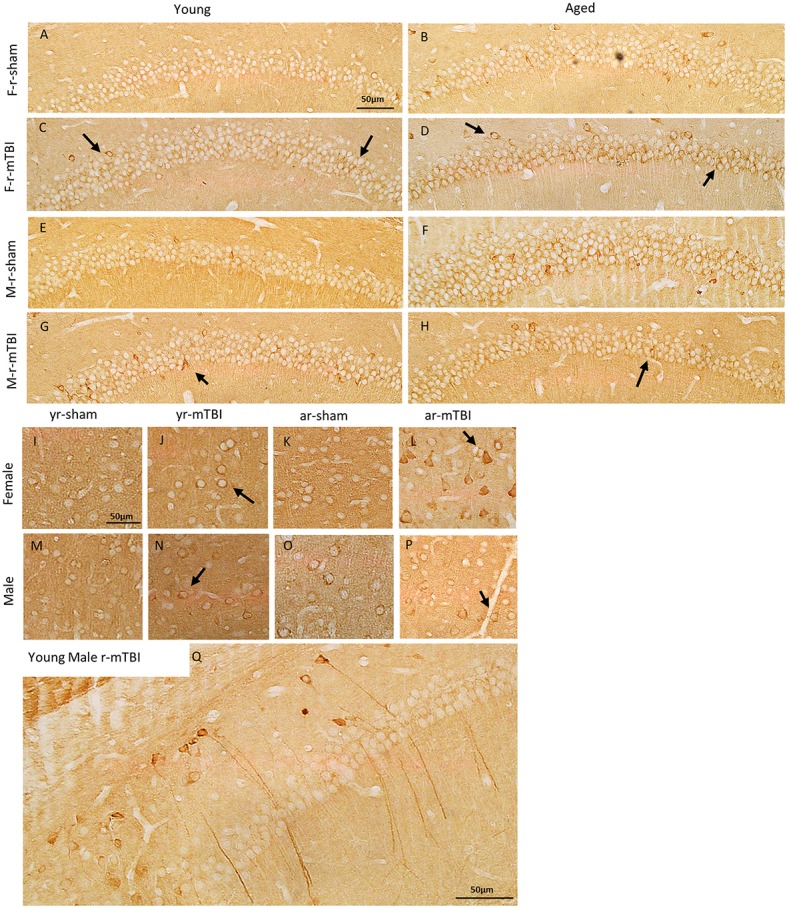
Immunohistochemical assessment of soluble phosphorylated tau pSer-202 (CP13) at approximately 0.5 mm lateral to midline in the CA1 region of the hippocampus (A–H) and in the neocortex (I–P) at 15 days after injury in young and aged female and male mice. Qualitatively, the r-mTBI group showed greater dendritic and membranous staining in both the CA1 (arrows in C,D,G,H) and cortical neurons (arrows in J,L,N,P) when compared to their respective shams. In in the aged group, intraneuronal immunoreactivity for CP13 was generally more intense within the perikarya and proximal apical dendrite of neurons in the hippocampal CA1 field of the male r-sham group (F). In addition, regardless of their sex and aged, some of the injured mice showed more intense CP13 immunoreactivity in long dendritic process when compared to their respective sham (Q).